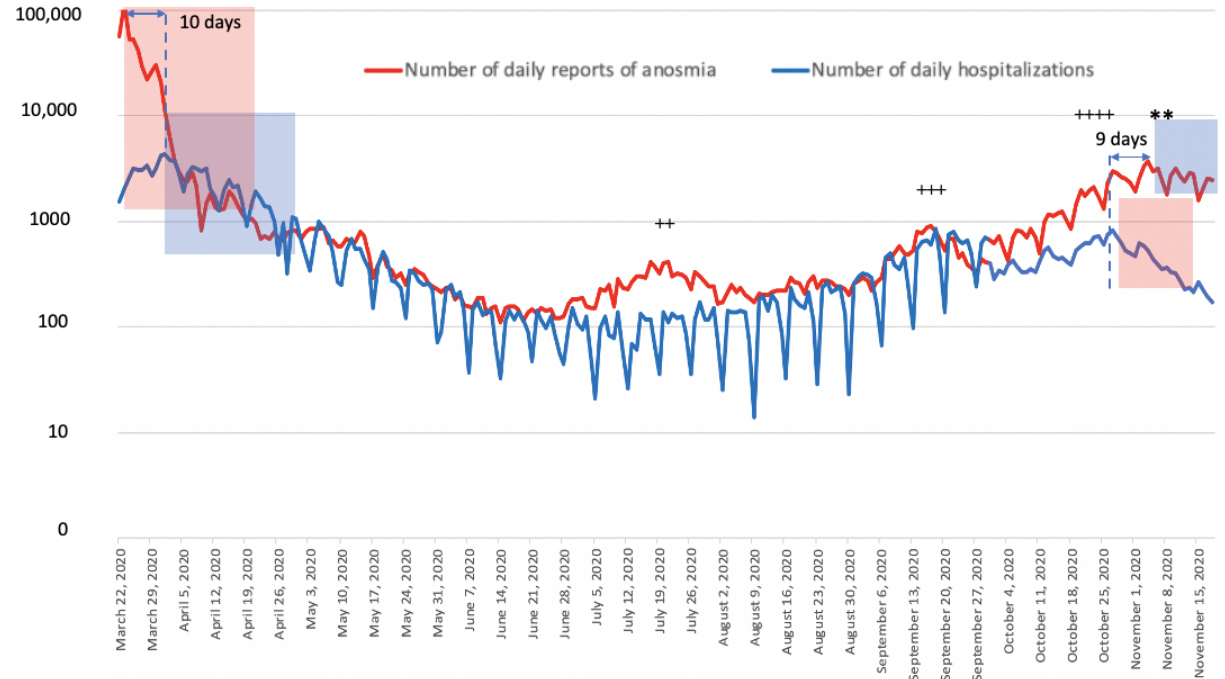
Figure 1. Comparisons between the daily number of hospitalizations and the daily reports of anosmia on the web-based self-triage app maladiecoronavirus.fr during the first and second peaks of the pandemic in France between March 21, 2020, and November 18, 2020. The first peak of hospitalizations occurred on January 4, 2020, and the second one occurred on April 11, 2020. In total, 4 peaks of daily reports of anosmia were recorded from the web-based app: March 23, 2020 (+), July 22, 2020 (++), September 16, 2020 (+++), and October 26, 2020 (++++). *Peak of hospitalizations during the first wave of the COVID-19 pandemic. **Peak of hospitalizations during the second wave of the COVID-19 pandemic. The graph shows a reduction in the number of connections 10 days before the reduction in daily hospitalizations during the first wave of the pandemic and 9 days before the reduction in daily hospitalizations during the second wave (semilog scale). Red transparent windows show the reduction in daily reports of anosmia, and blue transparent windows show the reduction in the number of daily hospitalizations during the first and second waves of the